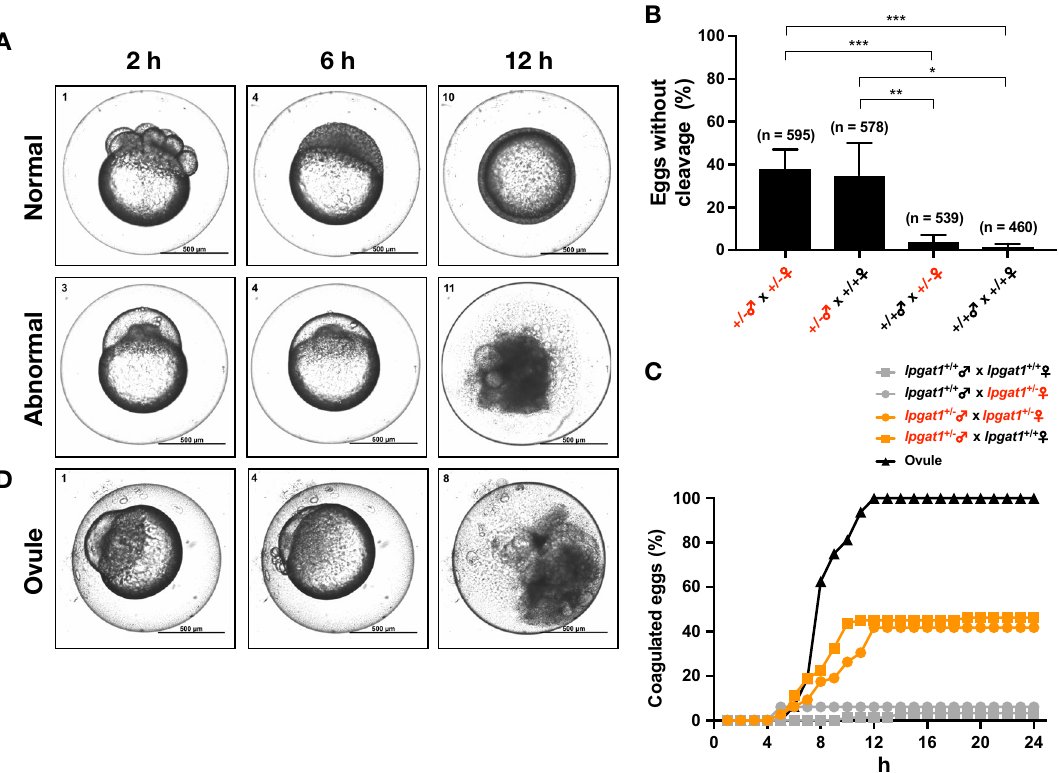
Figure 2. lpgat1 +/ − male zebrafish exhibited a reproductive defect. ( A ) Representative images of abnormal eggs resulting from crossing between lpgat1 +/ − male and wild-type female. The abnormal eggs showed no signs of cell division and, over time, became coagulated. The results from mutant 1 are shown. The elapsed time after mating is indicated at the top of the panels. Zen Pro software (Zeiss) was used to process the images. Scale bar, 500 µm. ( B ) Percentage of eggs with no sign of cell division at 6 hpf. Results from the crossing between the indicated genotypes are shown. For mutants 1 and 2, four genotype combinations of crosses ( lpgat1 +/+ males/ lpgat1 +/+ females, lpgat1 +/ − males/ lpgat1 +/+ females, lpgat1 +/+ males/ lpgat1 +/ − females and lpgat1 +/ − males/ lpgat1 +/ − females) were performed for four times each and the results of the same genotype combination were combined. The numbers of eggs analyzed are indicated on the top of each bar. Error bars are S.D. Statistically significant differences are marked with asterisk. * p < 0.05; ** p < 0.01, *** p < 0.001. Two-way ANOVA, Holm’s multiple comparison test was used. ( C ) Percentage of coagulated eggs overtime after mating. Results from the crossing between the indicated genotypes are shown. Crossing were performed for four times each. Representative data using mutant 1 are shown. Eighty eggs were buried in an agarose gel and evaluated based on the images by time-lapse observation. The result from ovules (unfertilized eggs) is also shown. ( D ) Representative images of ovules (unfertilized eggs) squeezed out of a wild-type female over time. Note that they showed no signs of cell division and, over time, became coagulated as in ( A, lower ). The elapsed time after the eggs were squeezed out is indicated at the top of the panel. Scale bar, 500